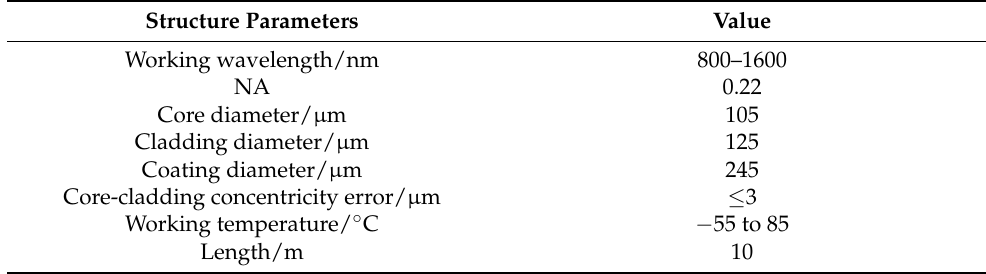
Table 1. Structural parameters of the optical fiber.